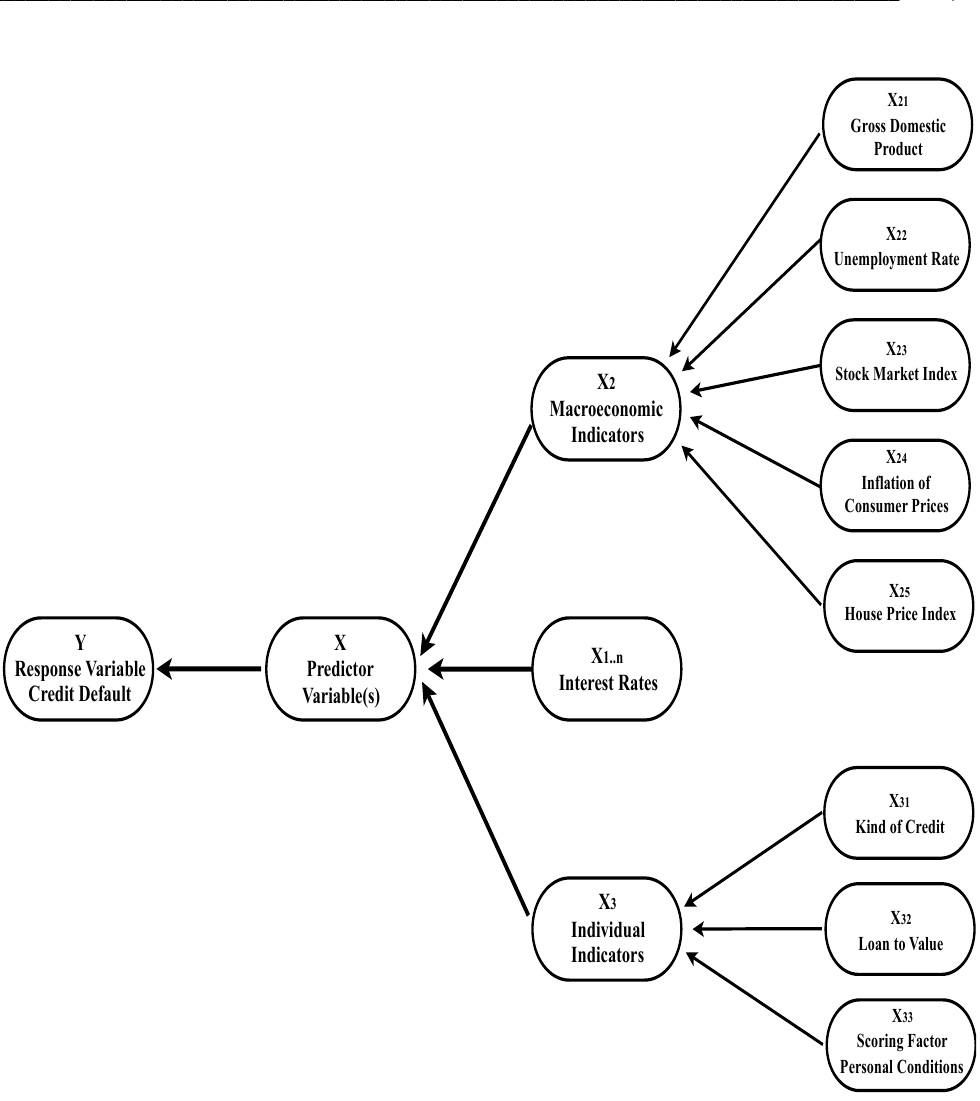
Fig. 1. Research model for credit defaults (developed by the